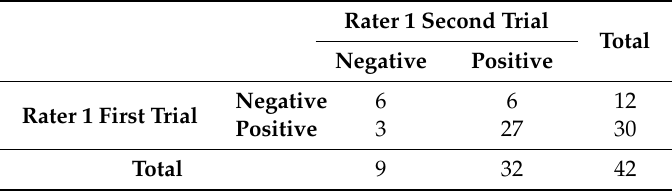
Table 2. Two by two contingency table for intra-rater agreement.